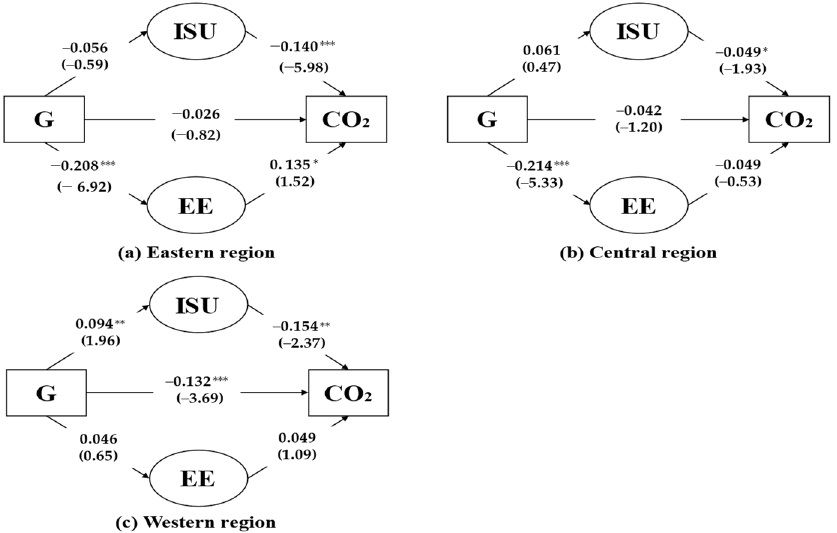
Figure 5. The effect of technological innovation on carbon emissions in eastern, central, and western regions. Note: *: p < 0.1, **: p < 0.05, ***: p < 0.01. z-values in regions. Note: *: p < 0.1, **: p < 0.05, ***: p < 0.01. z-values in parentheses.